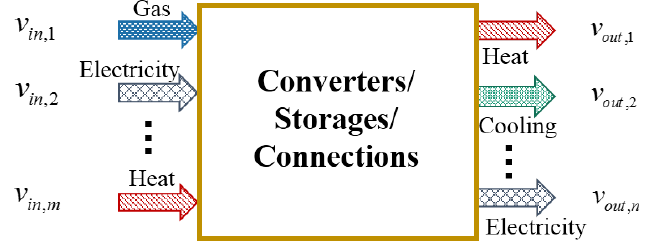
Figure 2. Standardized matrix modeling method of the integrated energy system.